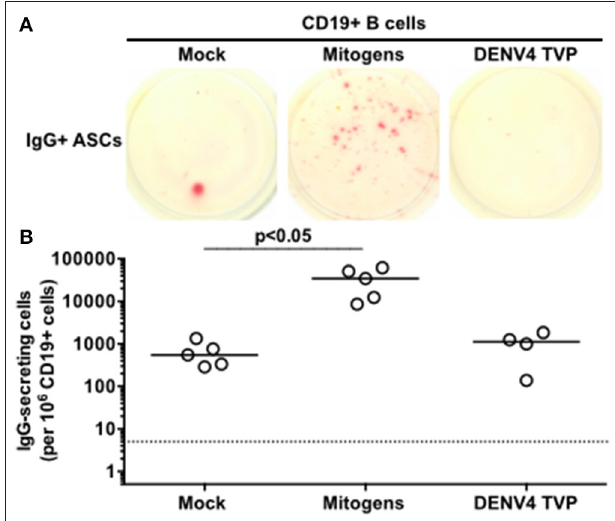
FIGURE 3 | Dengue virus does not trigger the ASC differentiation when incubated with isolated B cells. CD19 + B cells were isolated from PBMCs of six donors and five of them were tested in this assay, except for DENV4 TVP incubation ( n = 4 samples). (A) Representative data obtained from 6.6 × 10 4 CD19 + B cells harvested at day 7 of culture and added per well of ELISPOT plates to enumerate IgG-secreting cells in each culture condition. (B) Magnitude of IgG-secreting cells detected per 10 6 CD19 + B cells through